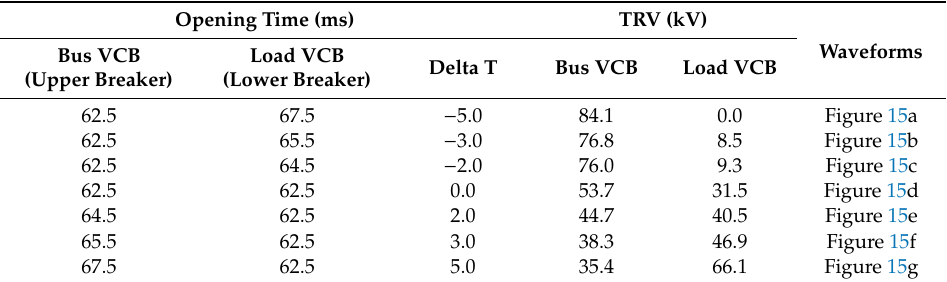
Table 5. Transient recovery voltage for the switchboard with a double circuit breaker